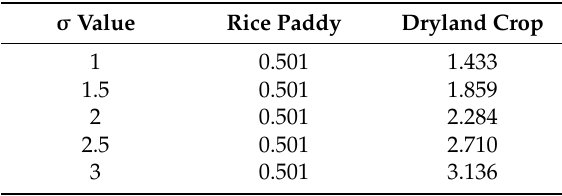
Figure 3. Three curves illustrating the effectiveness of the open-boundary locally weighted dynamic time warping (OLWDTW) method. The rice paddy curve is a man-made curve where the growing season section’s shape is identical to the reference curve. The dryland curve and reference curve are extracted from satellite time-series data. Table 1. Calculated OLWDTW distances between the reference curve and rice paddy curve and dryland crop curve with different σ values.